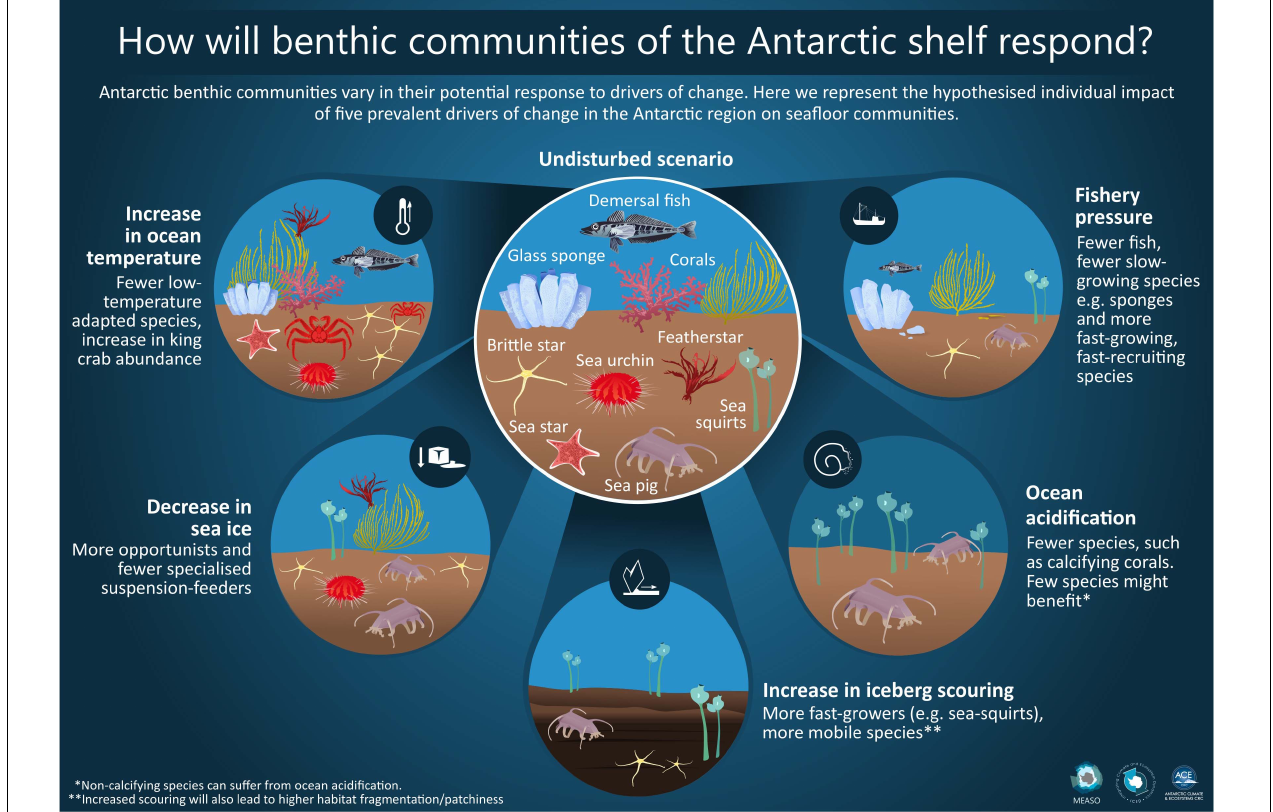
FIGURE 6 | Conceptual changes to an undisturbed seafloor community under five different impact drivers; increasing ocean temperature, decrease in sea ice, increase in iceberg scouring, ocean acidification and fishery pressure.